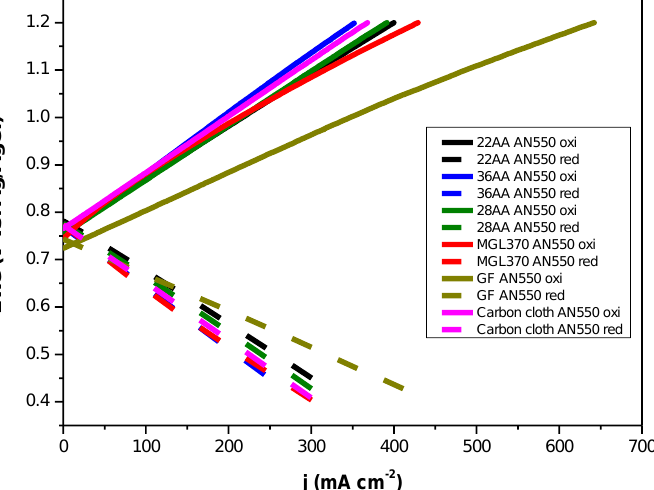
Figure 7. Polarisation curves for the annealed carbon materials. 3 M HBr/1 M Br 2 electrolyte, working electrode area 0.1 cm 2 . Temperature 25 °C.